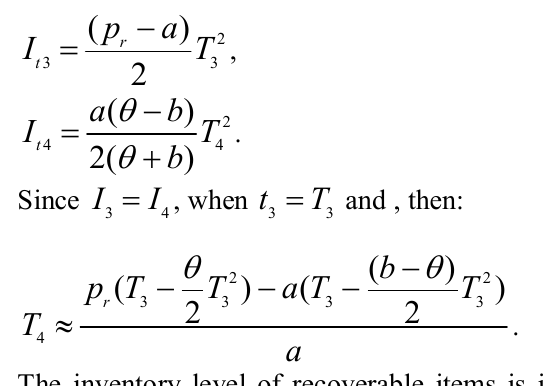
Fig. 3. Recoverable inventory level of 3 production setups and 1 rework